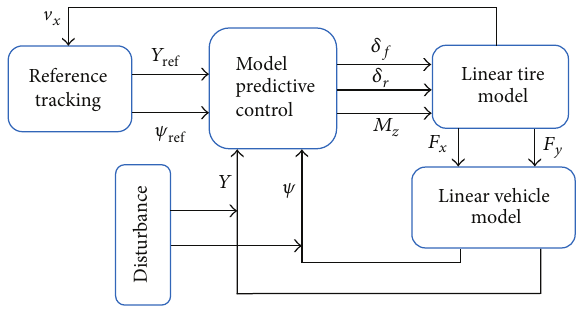
Figure 4: Predictive control